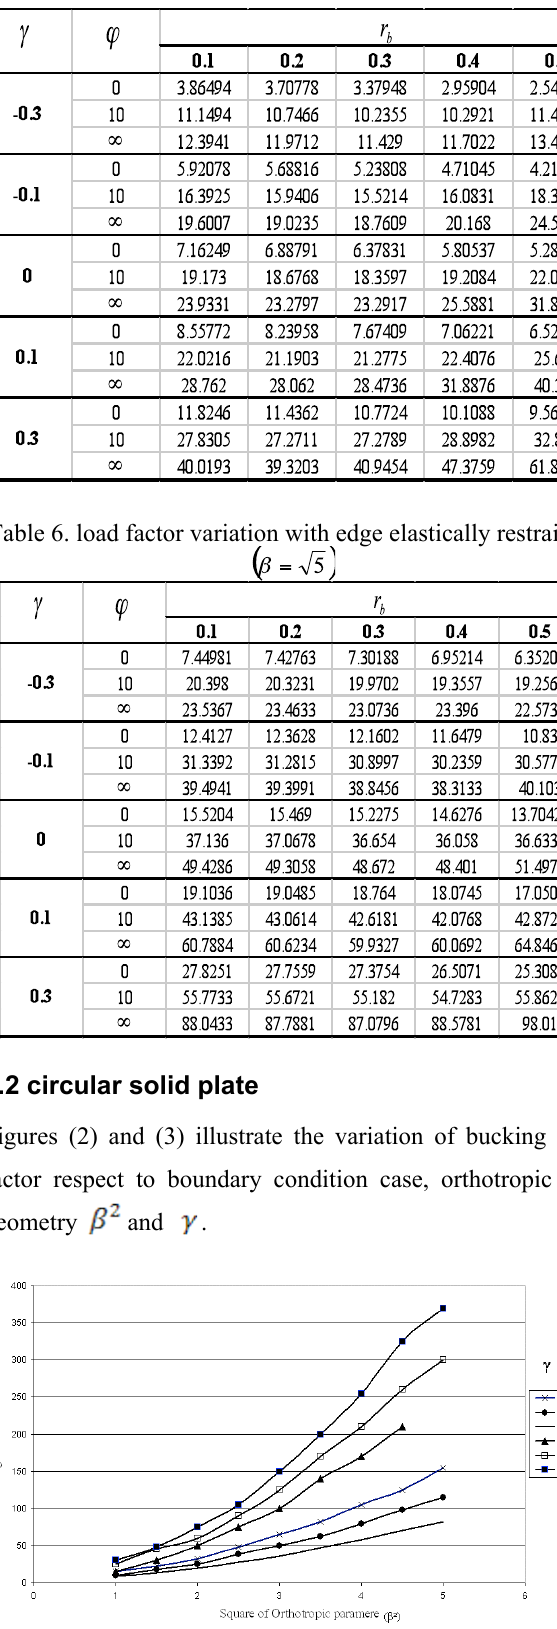
Fig. 2 variation of buckling load factor respect to orthotropic parameter and non-dimensional geometric parameter with clamped outer